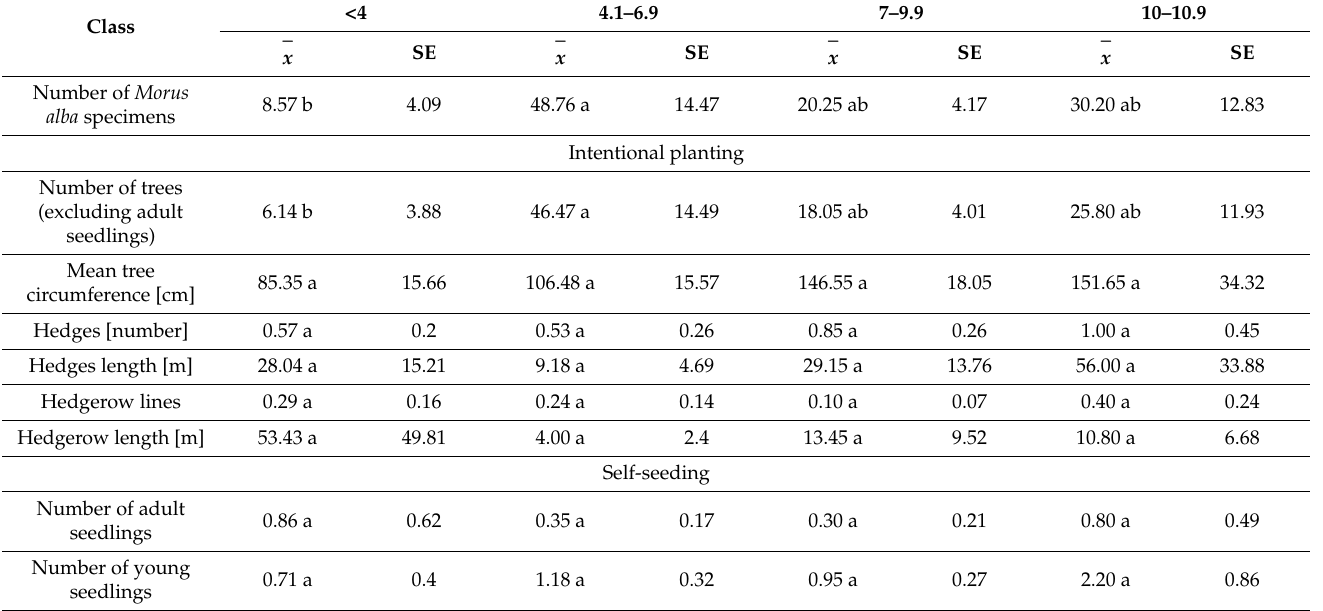
Table 3. Mean values along with standard errors of parameters describing natural (self-seeding) and artificial (intentional planting) renewal of Morus alba with regard to thermal variable. Different letters (a, b, ab) indicate significant differences as showed by the Tukey’s test or Kruskal–Wallis test ( p ≤